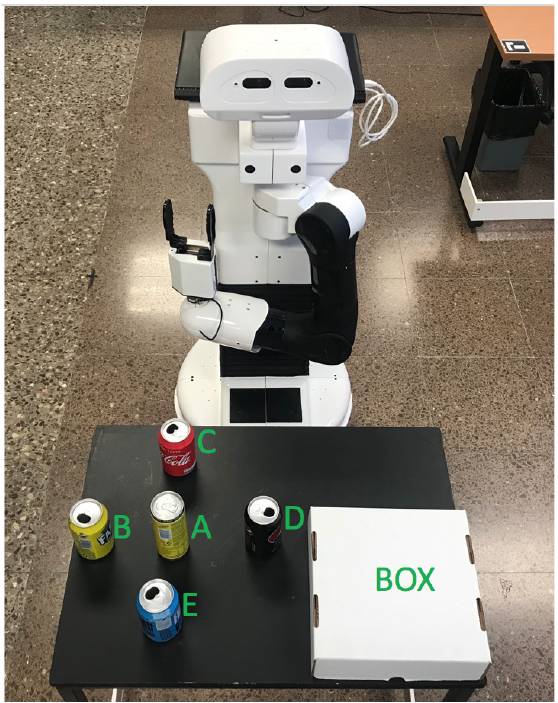
Figure 2. The initial scene where the robot requires placement of the object A within the box in the presence of geometric constrains.